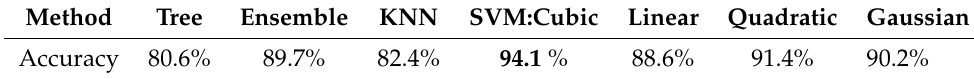
Table 3. Classification comparison of classifiers of MobiFit Method Tree Ensemble KNN SVM:Cubic Linear Quadratic Gaussian Accuracy